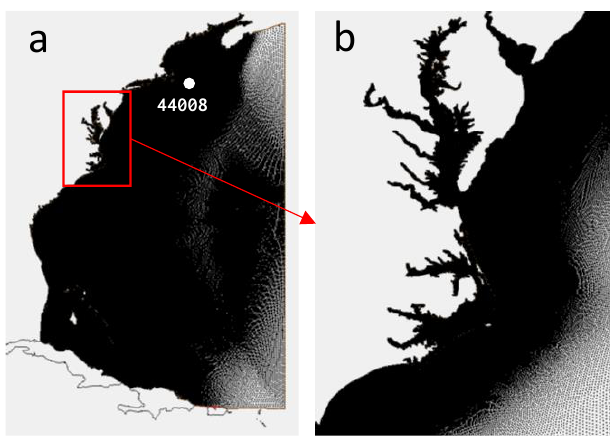
Fig. 3. UnSAWN model grid for U.S. East Coast (a) and zoomed-in near the Chesapeake Bay region (b).